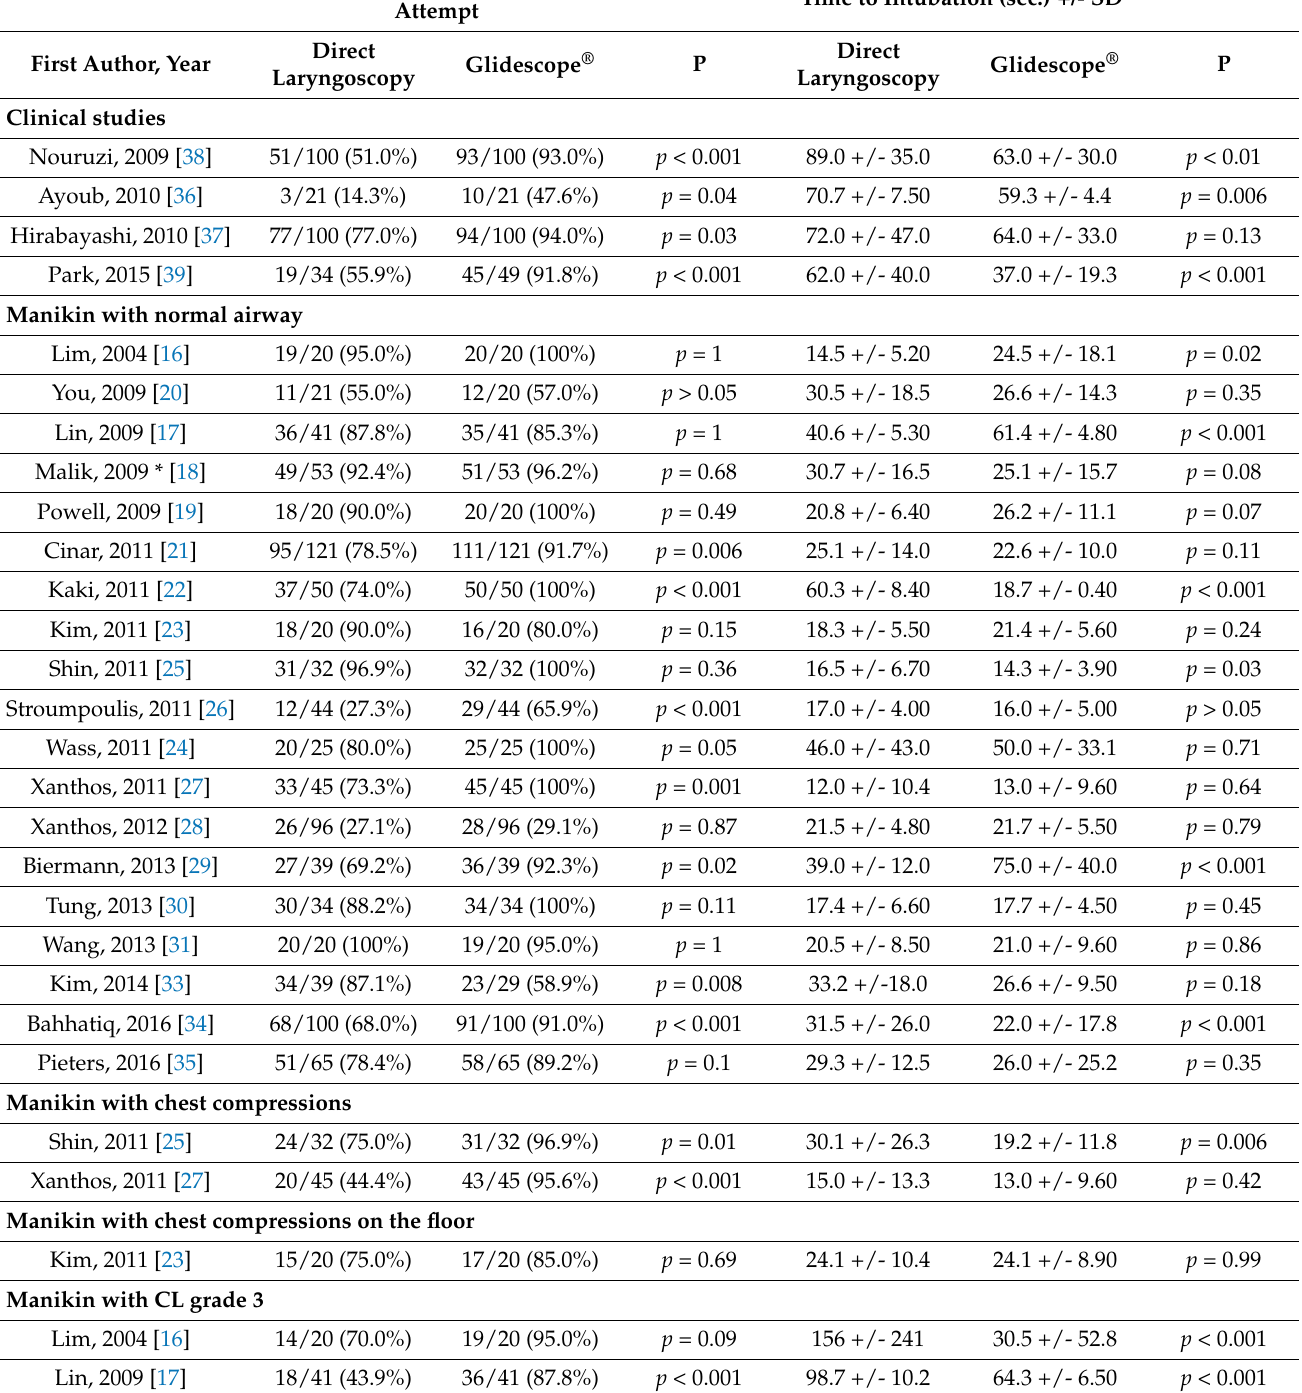
Table 2. Outcomes of clinical and manikin trials comparing Glidescope ® videolaryngoscope to direct laryngoscopy. We created separate rows in the table for several studies as they used different scenarios in the same study. (*) The data in this row include only the first scenario with normal airways in this study. (CL = Cormack–Lehane, sec. = seconds, SD = standard